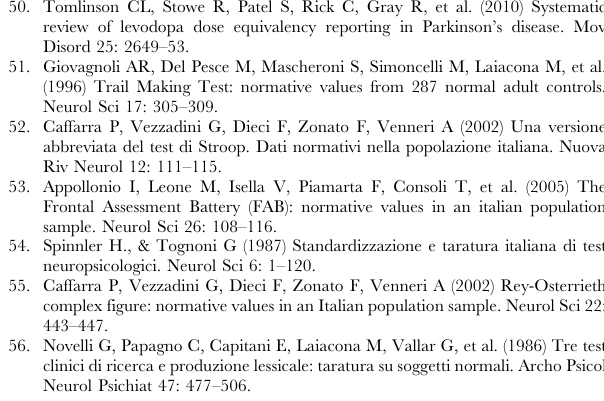
complex figure: normative values in an Italian population sample. Neurol Sci 22: